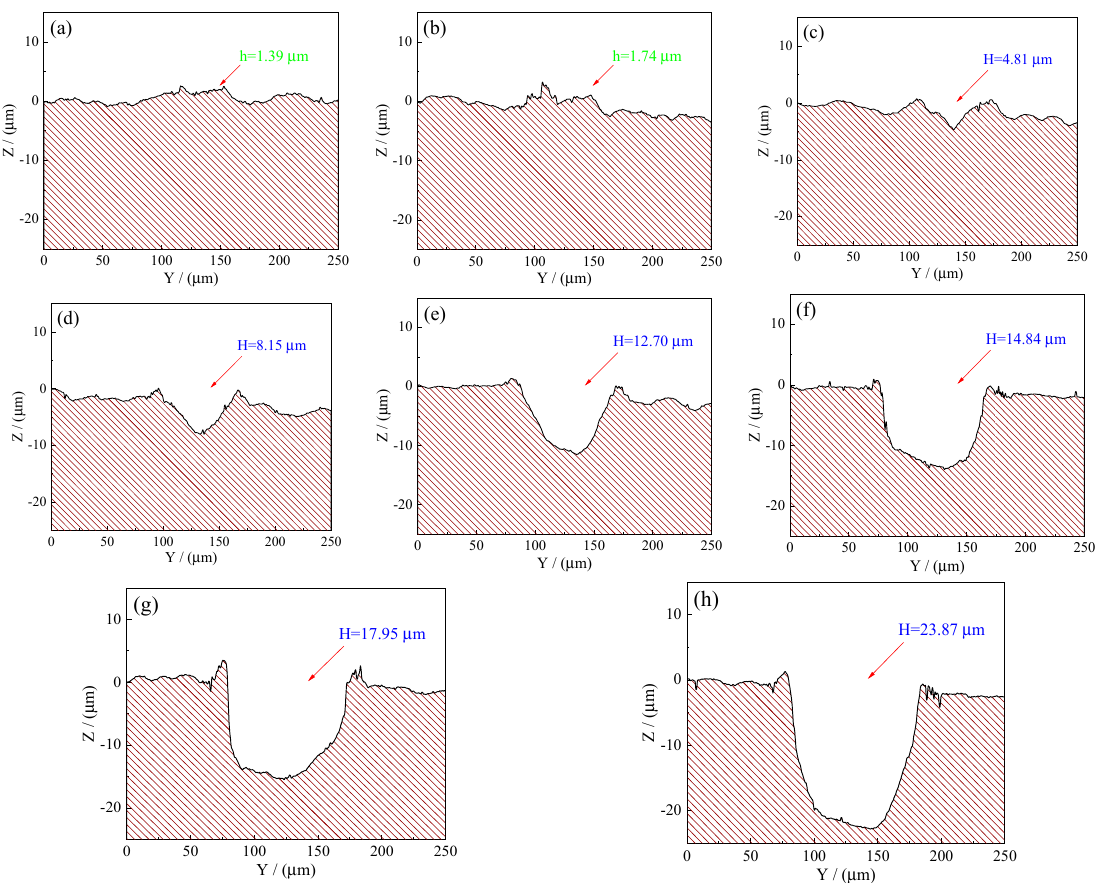
Figure 6. Experimental 2D cross-sectional profiles obtained from Figure 5: ( a ) 50 W; ( b ) 60 W; ( c ) 70 W; ( d ) 80 W; ( e ) 90 W; ( f ) 100 W; ( g ) 110 W; ( h ) 120